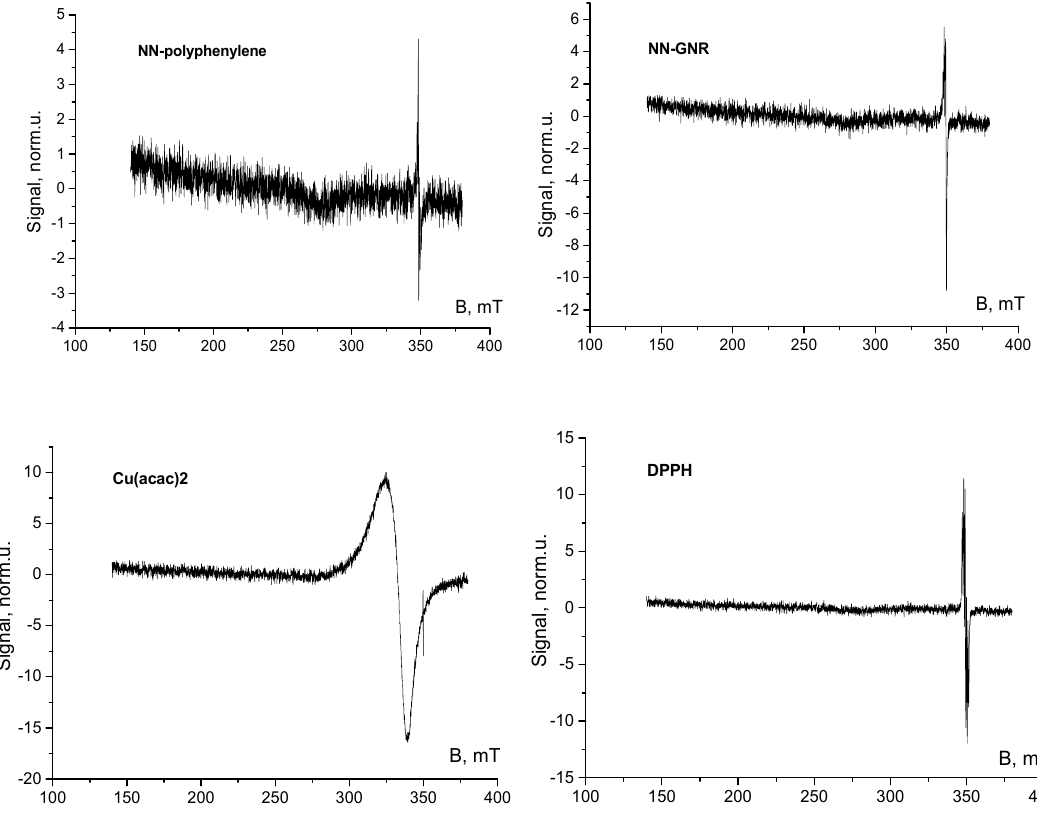
Figure 1. Typical broad spectra of the four samples taken in identical conditions. Cu(acac) 2 : cupric acetylacetonate; DPPH: 2,2-diphenyl-1-picrylhydrazyl; NN-GNR: spin-labeled graphene nanoribbon bearing nitronyl nitroxide substituents; NN-polyphenylene: nitronyl nitroxide-substituted polyphenylene.